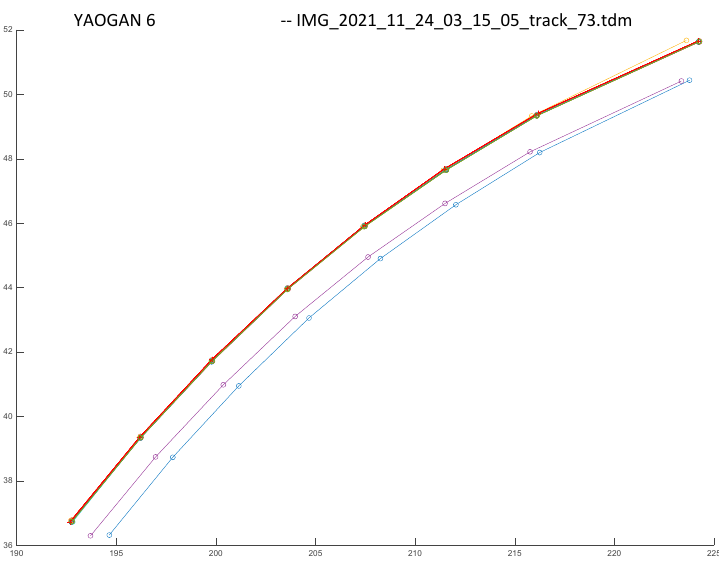
Figure 17. Angular coordinates for a single tracklet, computed with different calibration files. While most of the results are in agreement, outliers are present.